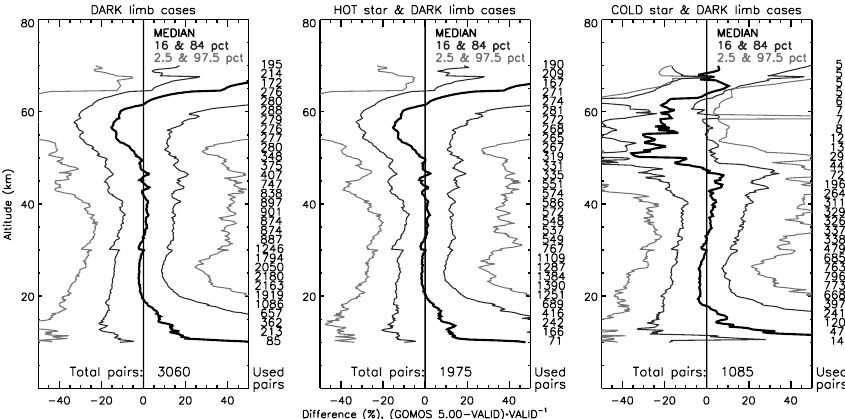
Fig. 6. As Fig. 4, but showing validation results for different star temperature groups. Left panel: all cases together; middle panel: observa- tions of hot stars; right panel: observations of cold Figure 6: As Figure 4, but showing validation results for different star temperature groups. 3 Left panel: all cases together; middle panel: observations of hot stars; right panel: 4 observations of cold stars. 5